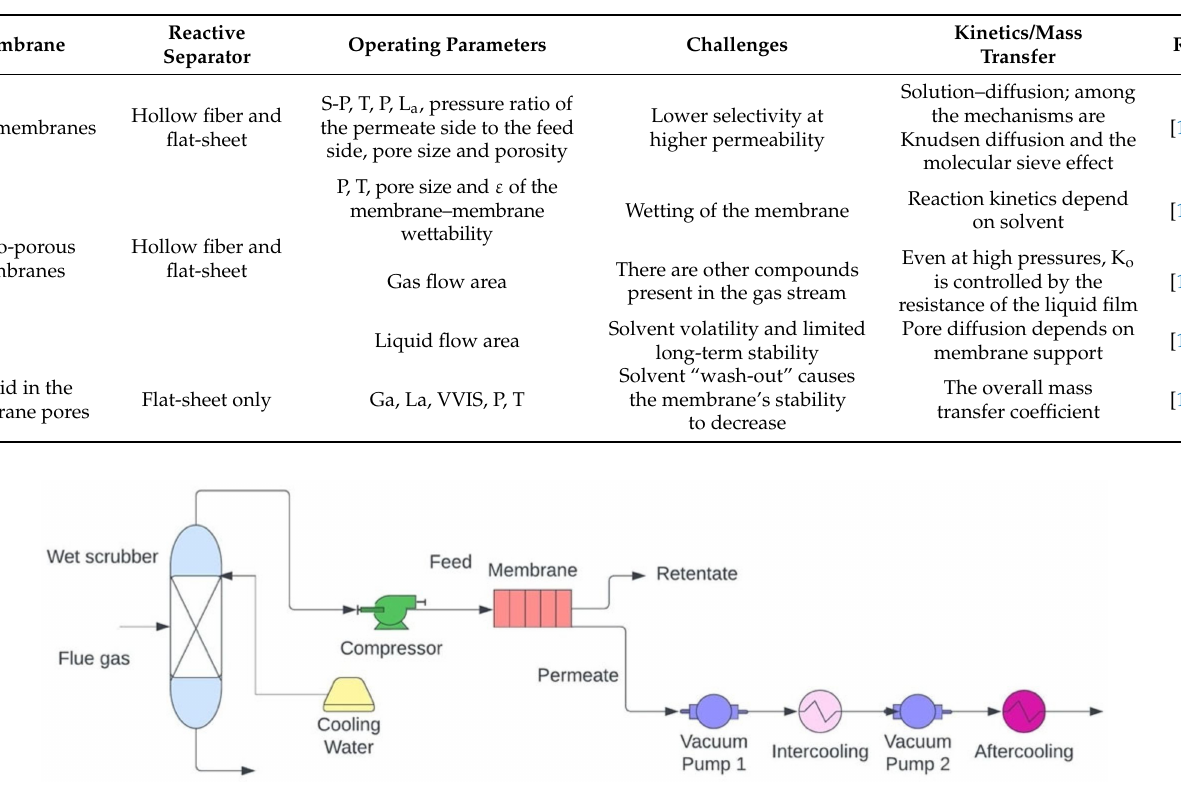
Table 6. Summary of membrane-based carbon capture.